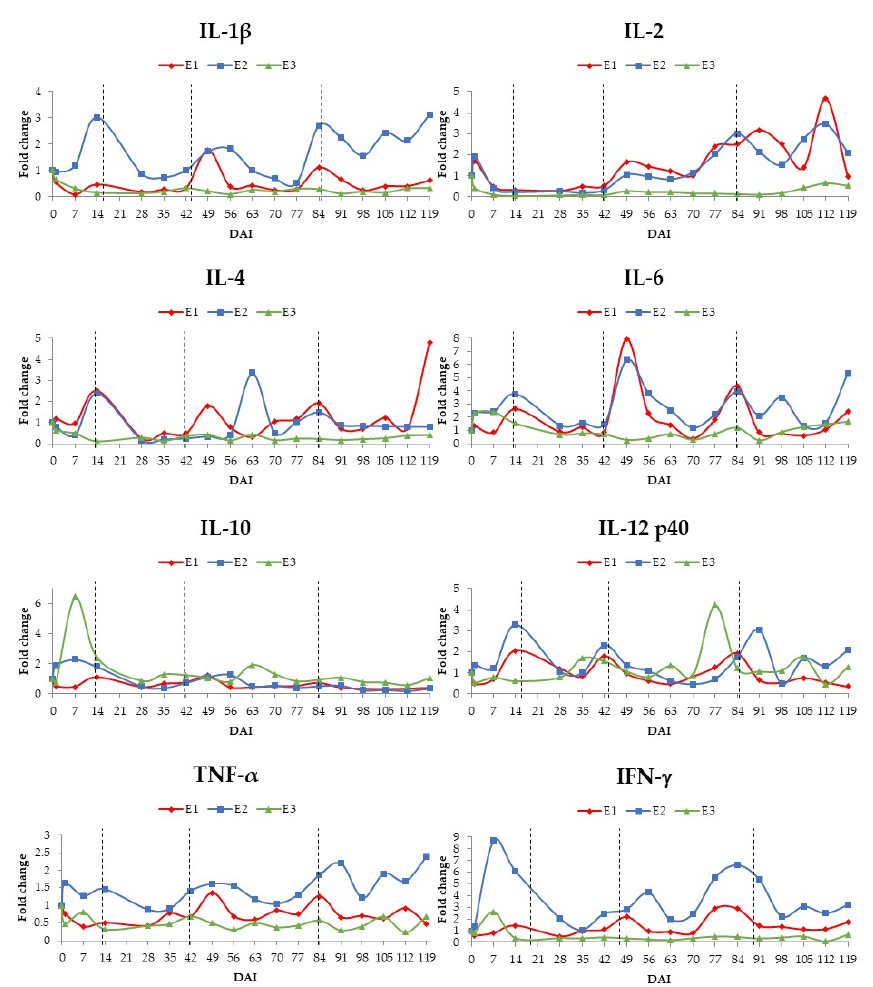
Figure 2. Relative quantification, by RT-qPCR, of IL-1 β , IL-2, IL-4, IL-6, IL-10, IL-12 p40, TNF α , and IFN γ expression in peripheral blood cells from three T. vivax experimentally infected cows (E1 to 3). The expression of the target cytokines was normalised to gapdh as a reference gene.